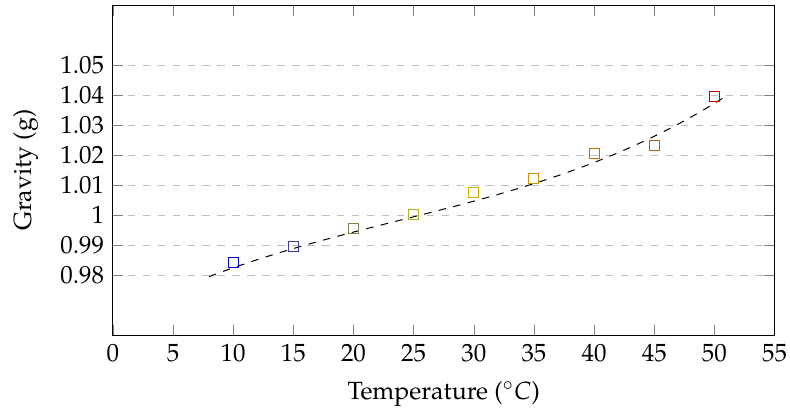
Figure 6. Accelerometer gravity measurements in temperature range 10–50 ◦ C.